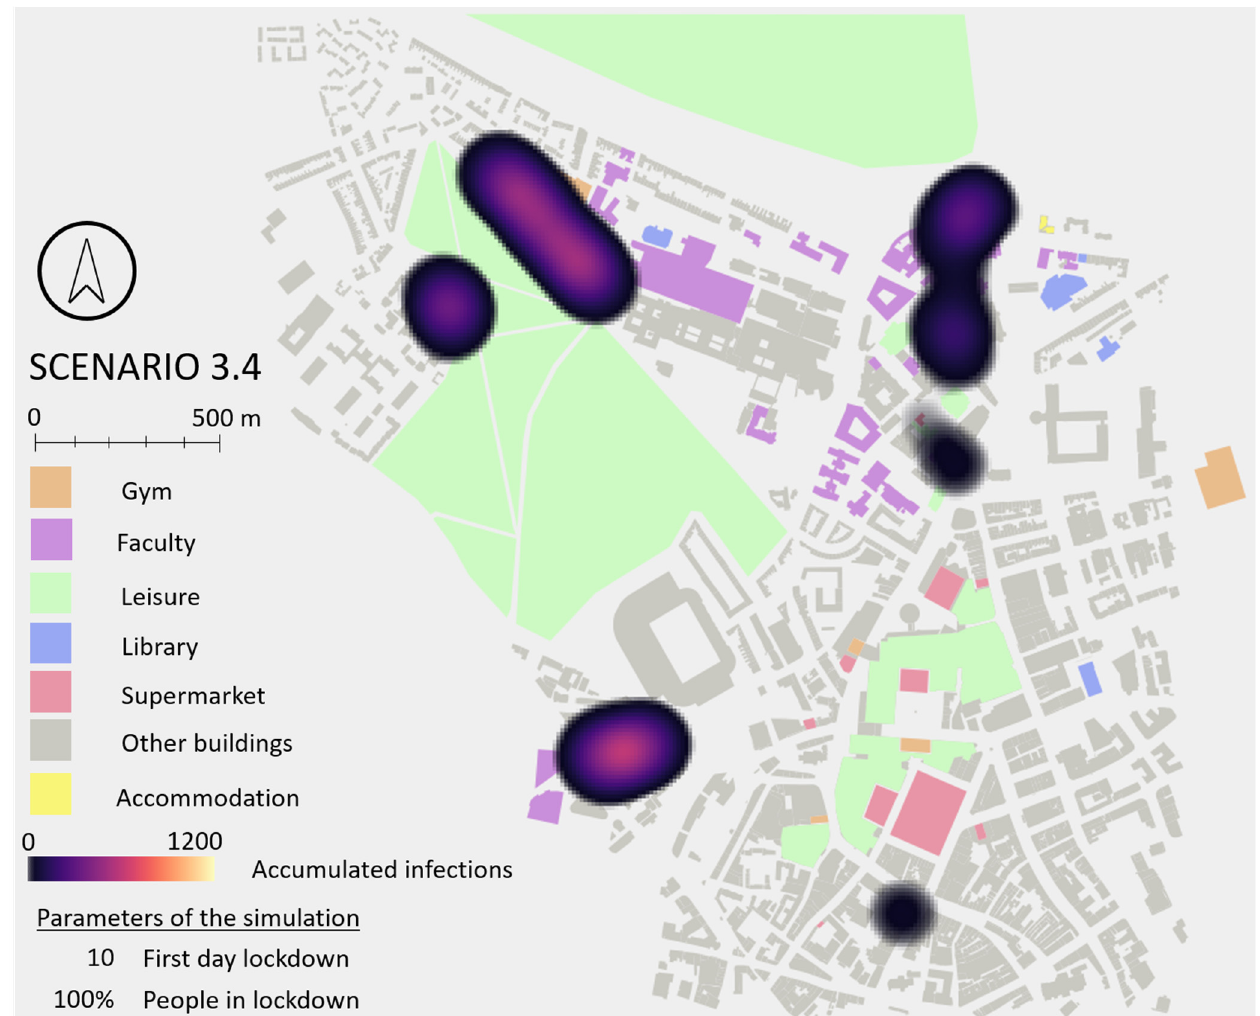
Figure A7. Heat map for Scenario 3.4 (100% students in lockdown from Day 10) showing the areas (in light yellow) where more infections were produced. A reduction in both main areas highlighted in Scenario 1 can be observed, as less infections are produced due to the implementation of the lockdown. Accommodation buildings remain with a high level of infection due to students’ schedule was cancelled, spending the whole day in the accommodation. © Crown copyright and database right 2020.